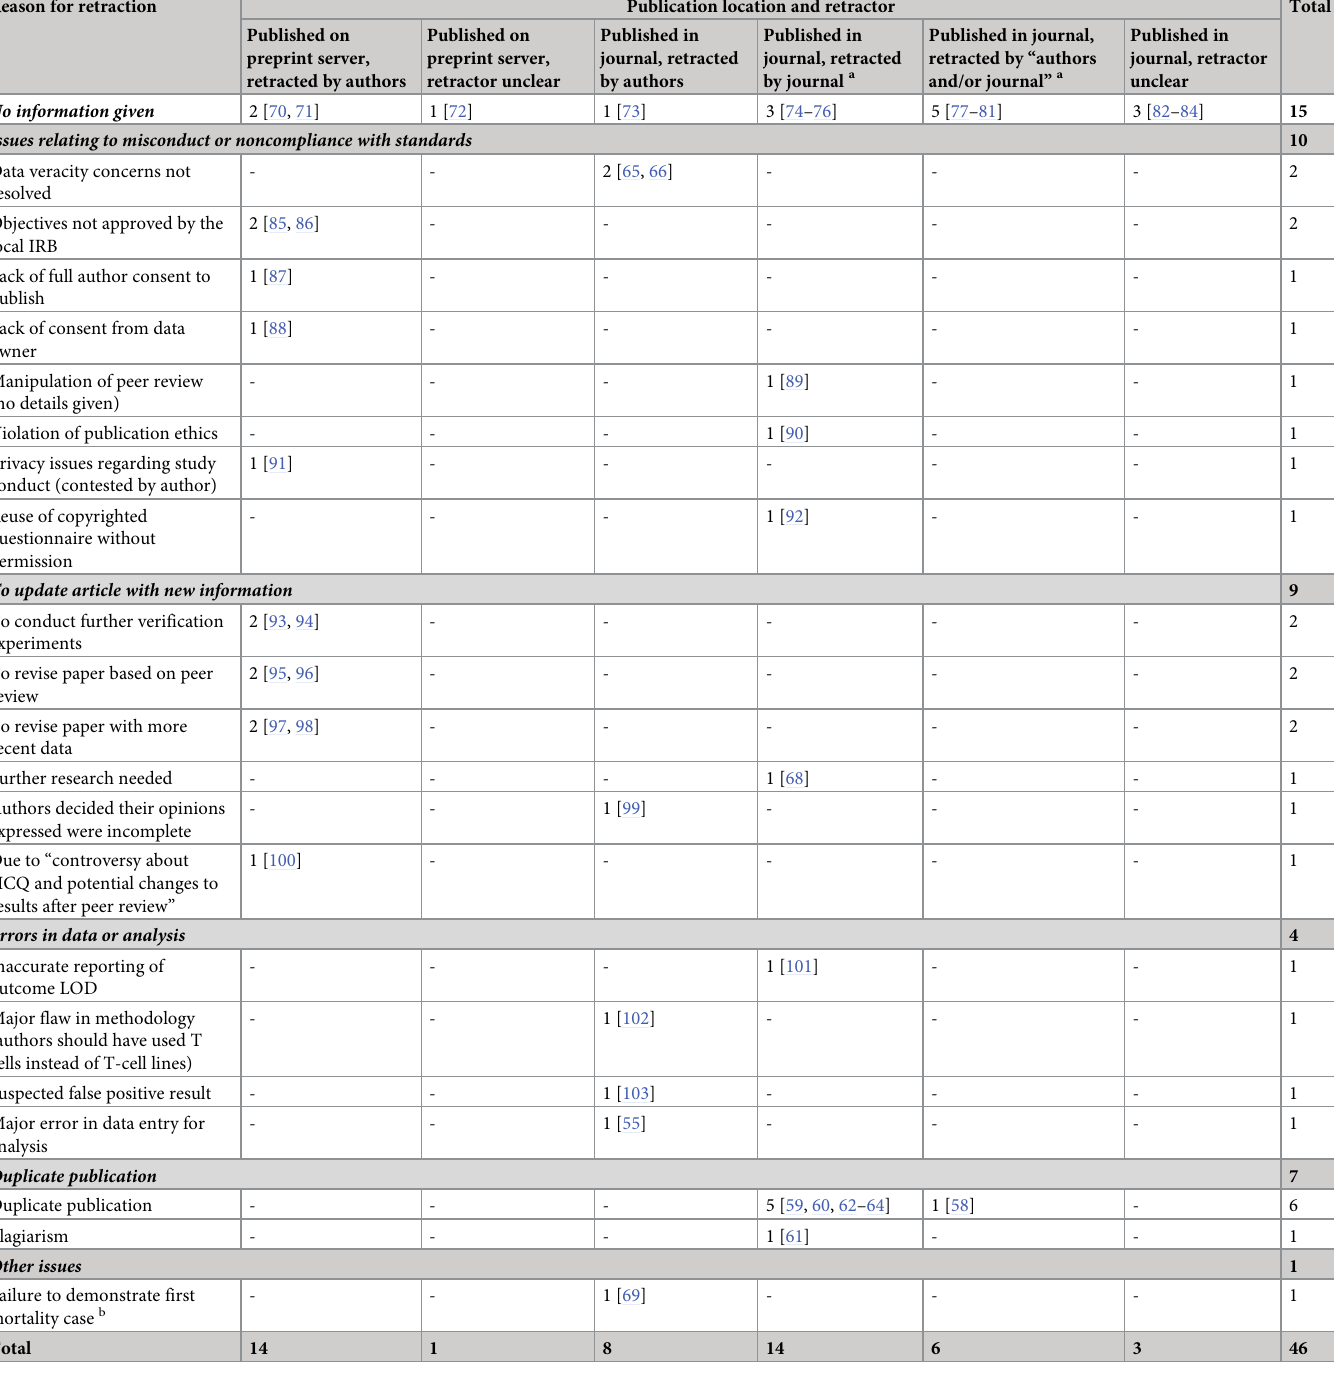
Table 1. Reasons for the retraction of COVID-19 research papers up to 19 th December